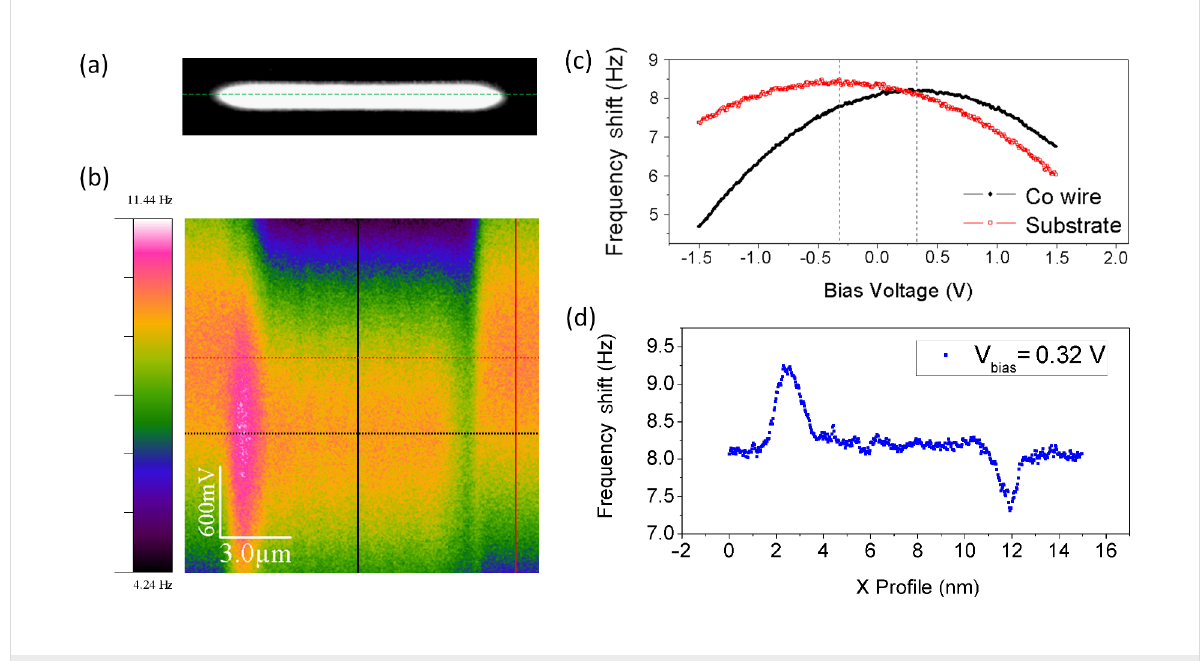
Figure 2: (a) Topography of the Co wire. The dashed line corresponds to continuous scanning along the profile while varying the bias voltage. (b) Frequency shift signal measured in the 3D mode (acquired at a distance of 100 nm). The fast scan corresponds to the x -axis scan all along the main axis of the Co wire and the slow scan is the bias voltage applied between the tip and the sample. (c) Frequency shift curves measured along the vertical profiles marked in (b) that correspond to the Co wire (black line) and substrate (red line). (d) Frequency shift measured along the wire at V bias = 320 mV (horizontal dashed black line marked in Figure 2b). The oscillation amplitude was A = 7 nm and the scan rate was 1